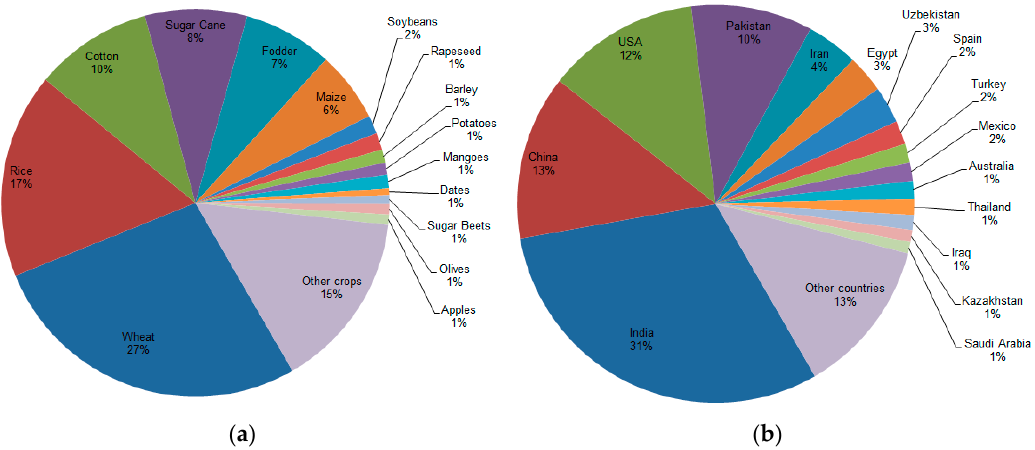
Figure 3. The unsustainable blue WF related to crop production: ( a ) Contribution of different crops toward the global blue unsustainable blue WF of crop production; ( b ) location of the unsustainable blue WF of crop production. Data source from Mekonnen and Hoekstra [81].